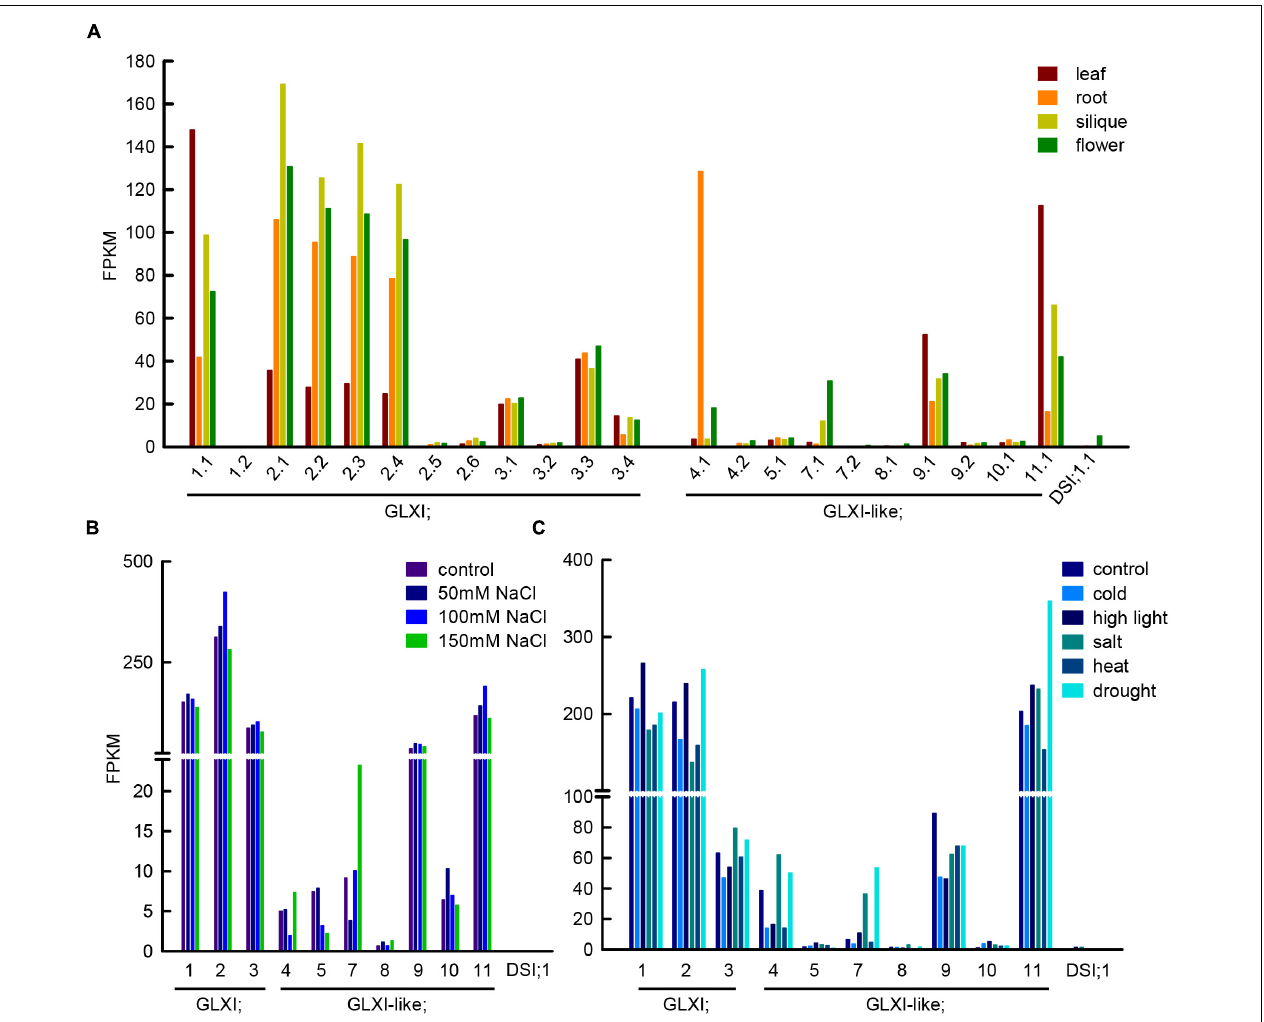
FIGURE 2 | Transcript abundance of GLXI and GLXI-like splice forms and gene expression under abiotic stress conditions. (A) FPKM (fragments per kilo base of exon per million fragments mapped) values of GLXI and GLXI-like splice forms in Arabidopsis leaf, root, siliques, and flowers. Raw data was taken from Liu et al. (2012) (PRJNA168212). (B) GLXI, and GLXI-like transcript abundance in FPKM in 21-days-old Arabidopsis plants after 24 h treatment with 50, 100, and 150 mM NaCl. Raw data taken from Shafi et al. (2015) (PRJNA217812). (C) GLXI, and GLXI-like transcripts in FPKM in whole 12-days-old Arabidopsis seedlings after 24 h of abiotic stress exposure. Raw data taken from Filichkin et al. (2010) (SRA009031). Raw data was re-mapped with high stringency to the TAIR 10 annotation as described in Schmitz et al.